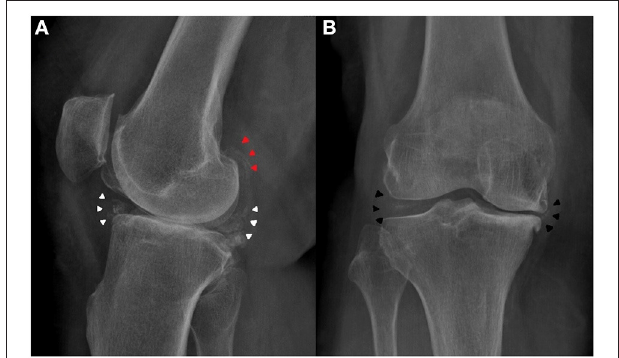
FIGURE 1 | Preoperative knee X-ray of the patient. (A) Lateral view showed meniscus (white arrowheads) and gastrocnemius tendon (red arrowheads) calcification. (B) Antero-posterior view showed medial and lateral meniscus calcification (black arrowheads).